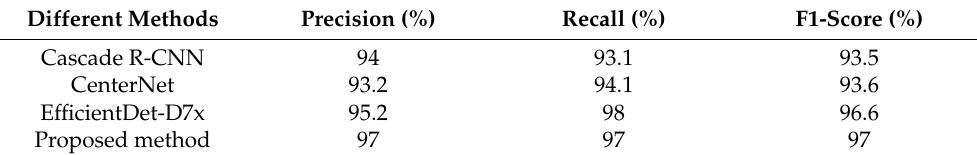
Table 7. Tri-partite measures of different methods.